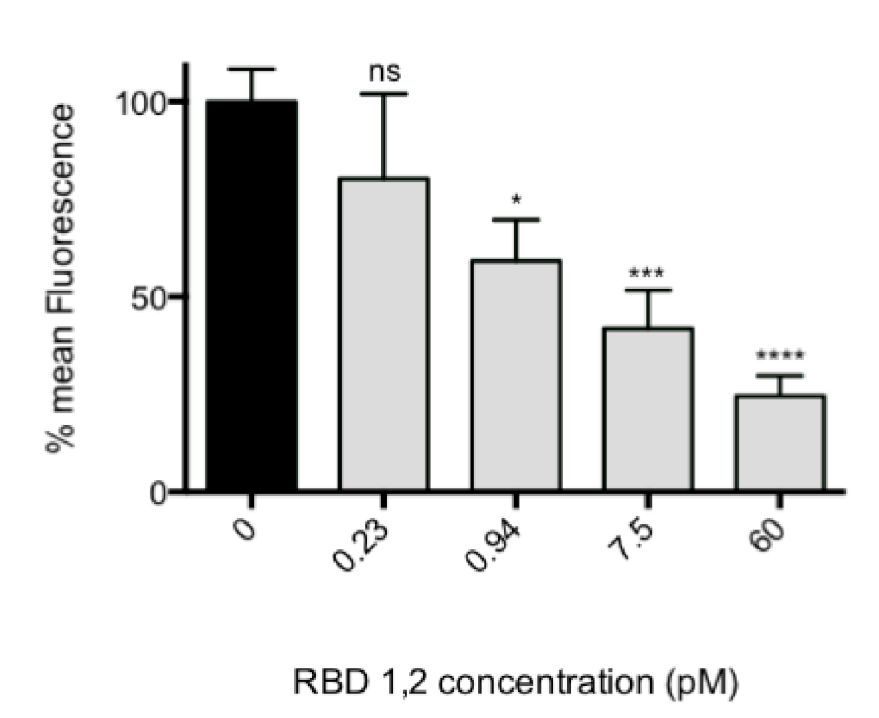
Figure 3. RBD1,2 vs. virus competition assay with HEp-2 cells, unattached virus removed. Note that 60 pM of mini-protein is sufficient to reduce virus replication by 80%. p < 0.0001, one-way ANOVA, average of 5 experiments. Bonferroni’s multiple comparison test. ns, not significant; *, p < 0.05; ***, p < 0.001; ****, p <